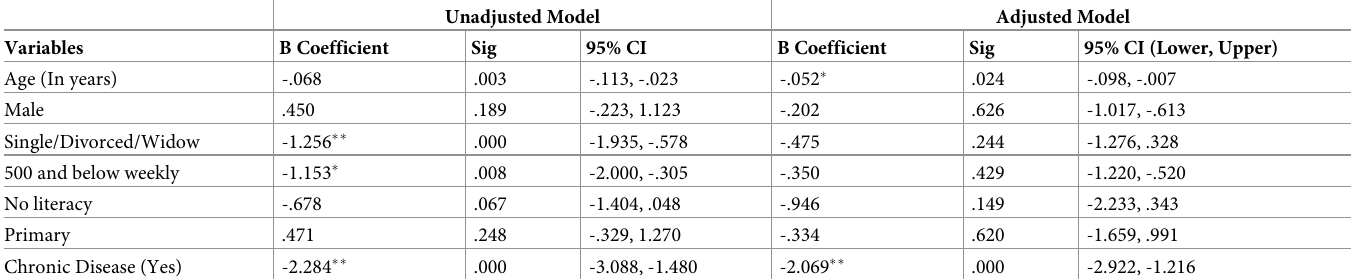
Table 3. The results of unadjusted and adjusted models of linear regression analysis predicting quality of life of indigenous people by age, gender, marital status, income education, literacy, and presence of chronic